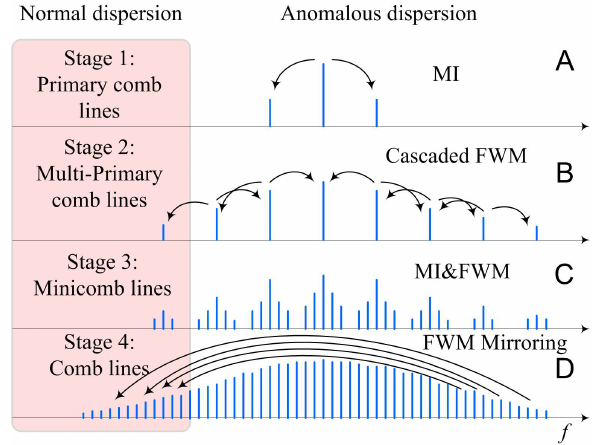
Figure 16: The dynamics of Kerr comb formation. (A) Stage 1: pri- mary comb line formation by MI, (B) stage 2: multiprimary comb line formation by cascaded FWM, (C) stage 3: minicomb line forma- tion by combination of MI and cascaded FWM, and (D) stage 4: final comb line